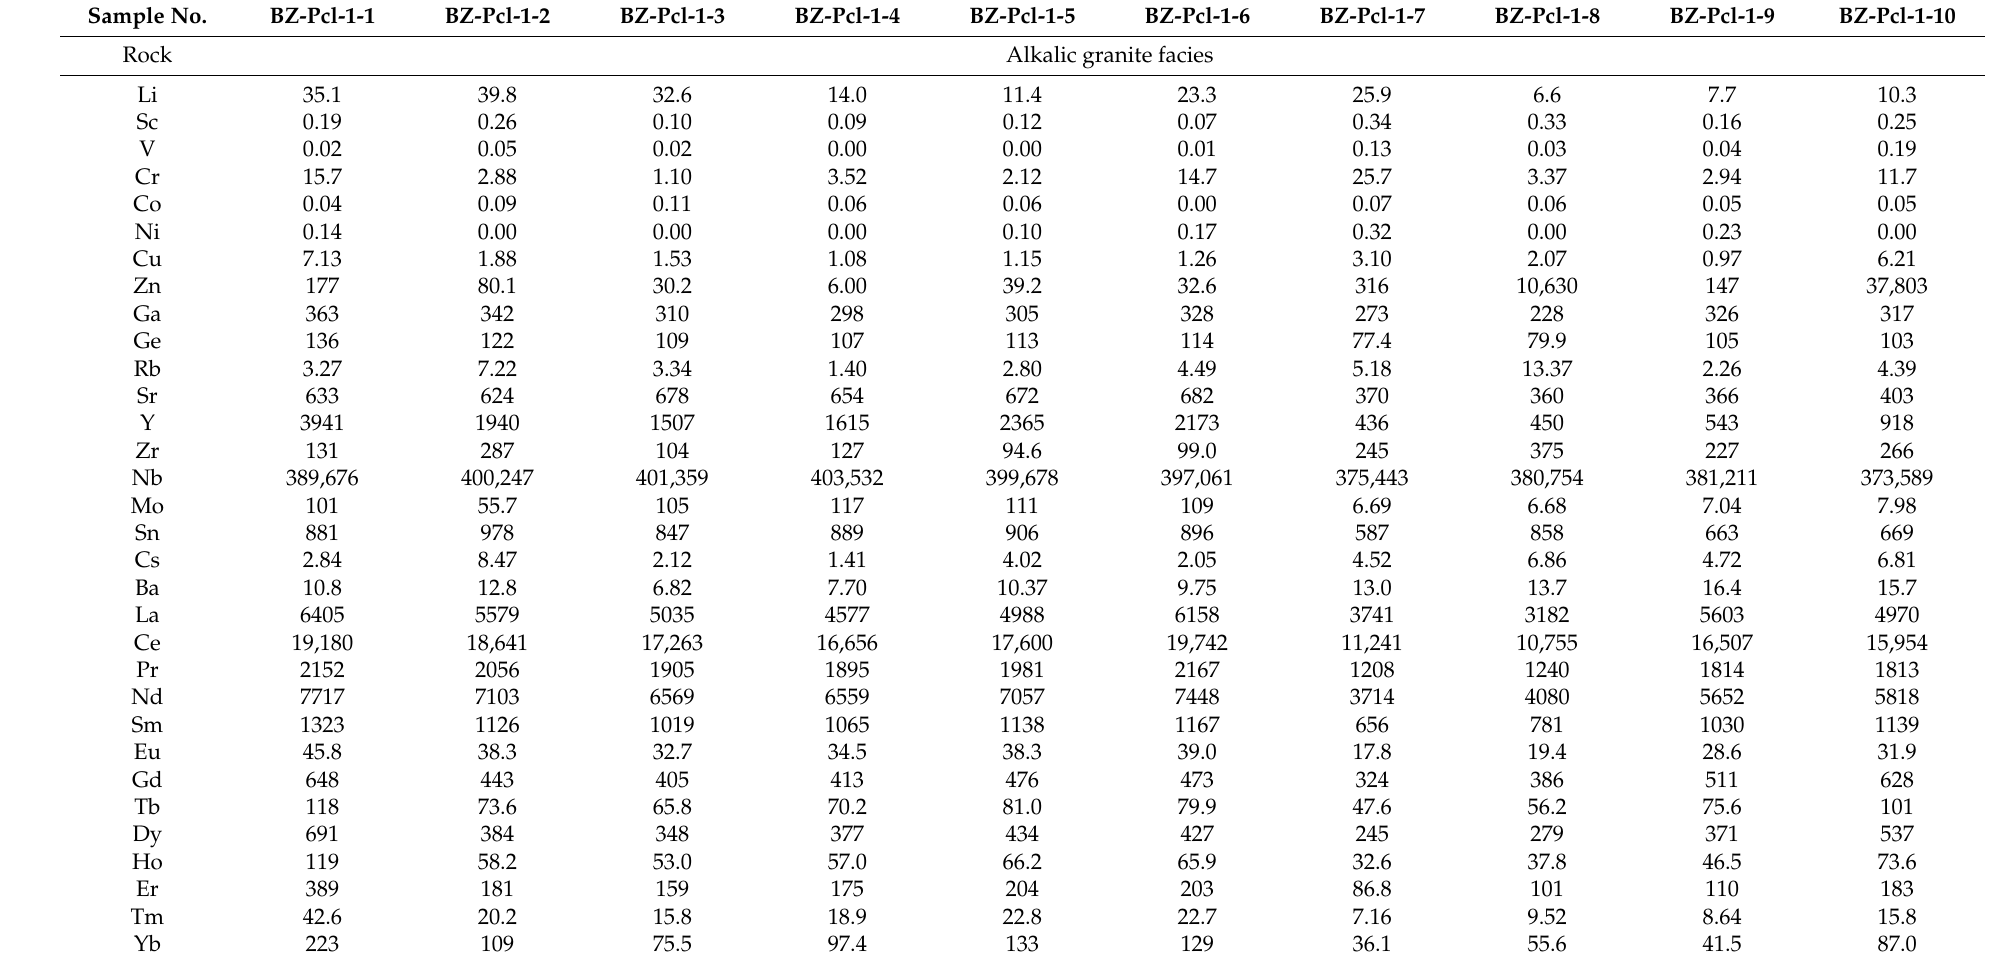
Table 2. Trace element content of pyrochlore supergroup minerals from the Boziguoer deposit. Sample